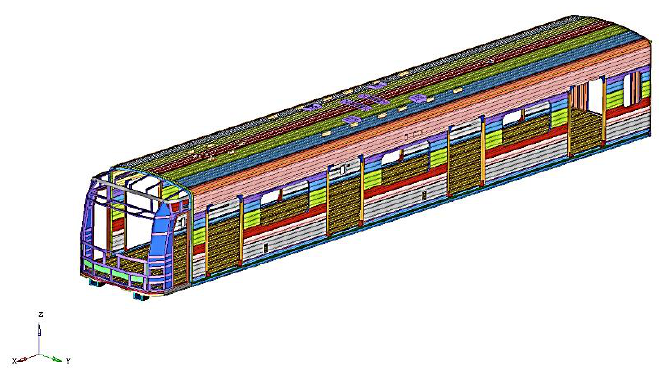
Figure 22. 3D design of the railway vehicle body.